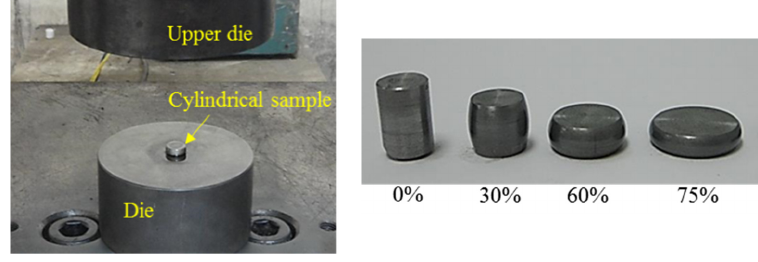
Figure 2. Compression experiment and compressed cylindrical samples at 0%, 30%, 60% and 75% reductions.